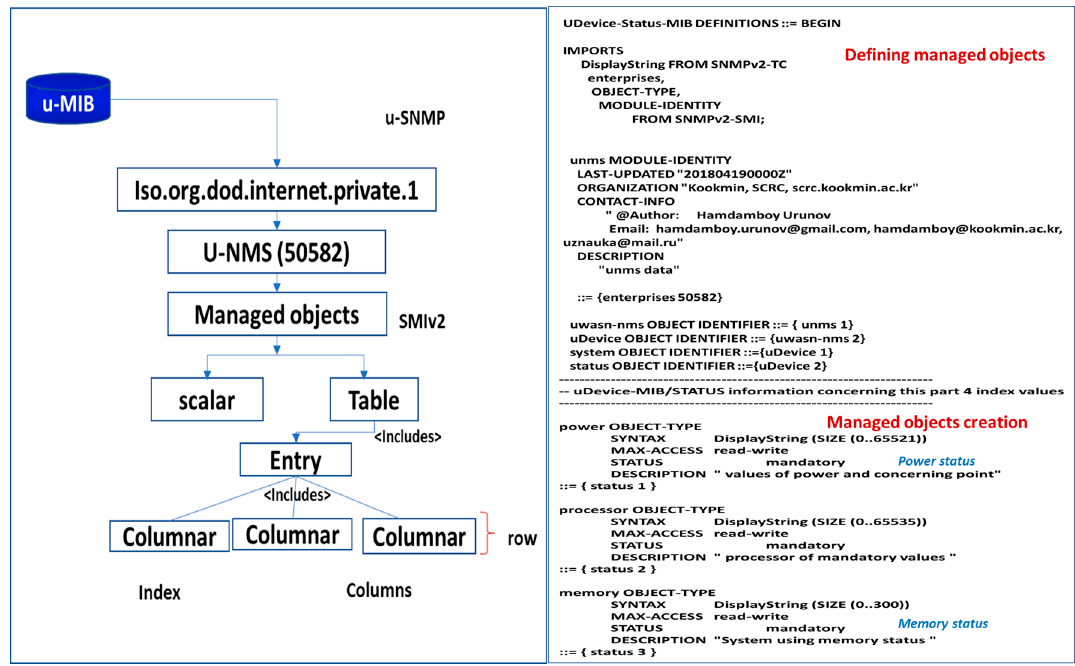
Figure 7. u-MIB designing and defining of managed objects (MOs) in u-SNMP [88],[90].